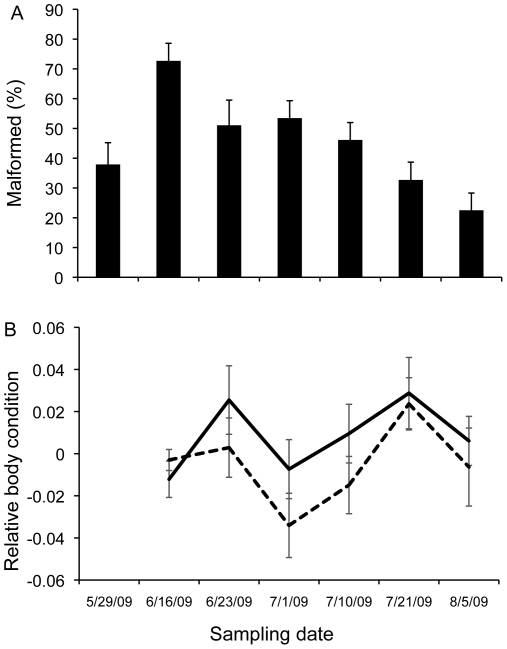
Estimates of malformation frequency and frog body condition over the summer of 2009.(A) Frequency of malformations in metamorphic chorus frogs over time. (B) Relative body condition of normal (solid line) and malformed frogs (broken line). N = 1388 sampled frogs.